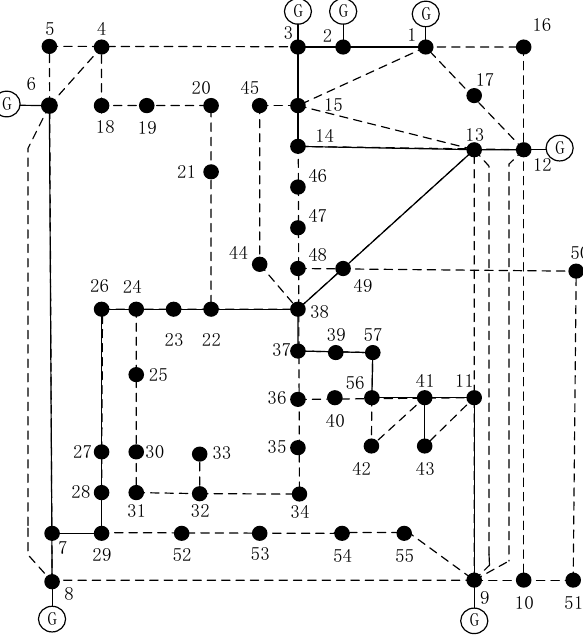
Figure 5. The final restoration backbone network.